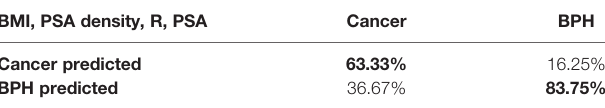
Bold values indicate signi fi cant p-values lower than 0.05.